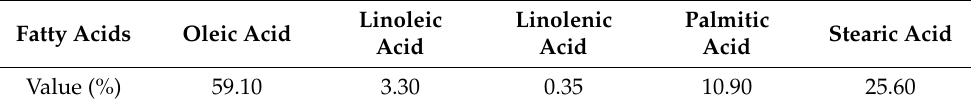
Table 3. Percentage of various fatty acids.